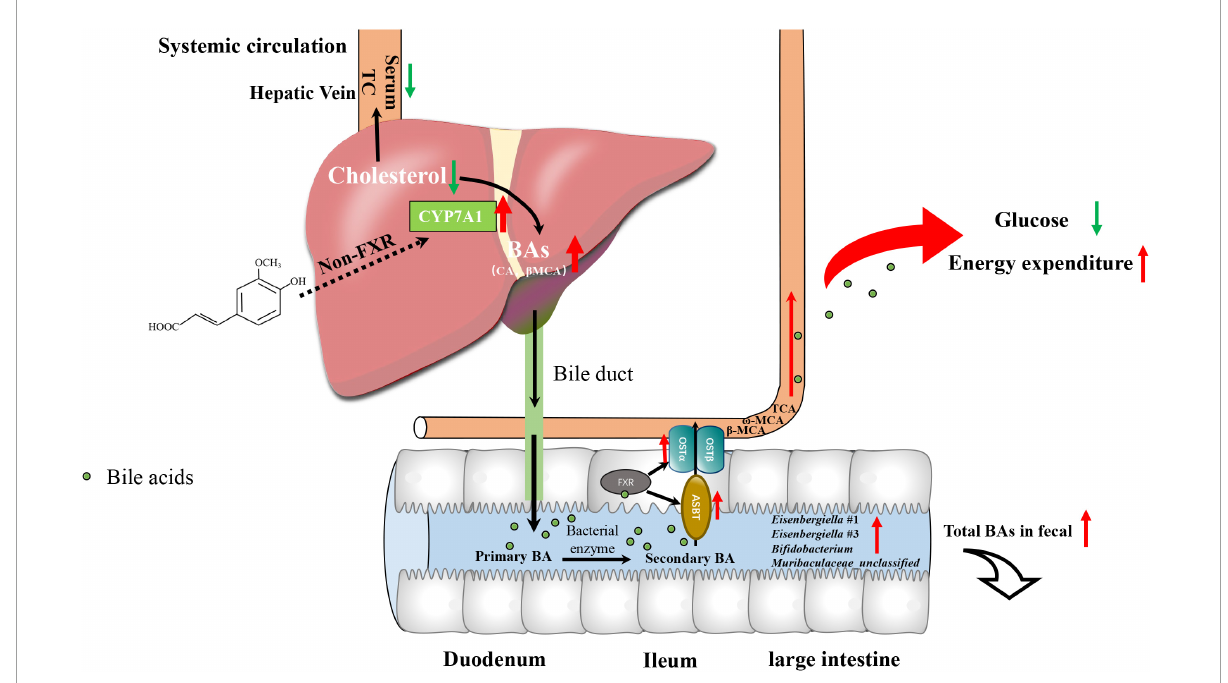
FIGURE7 Proposed mechanism for the cholesterol-lowering effects of FA